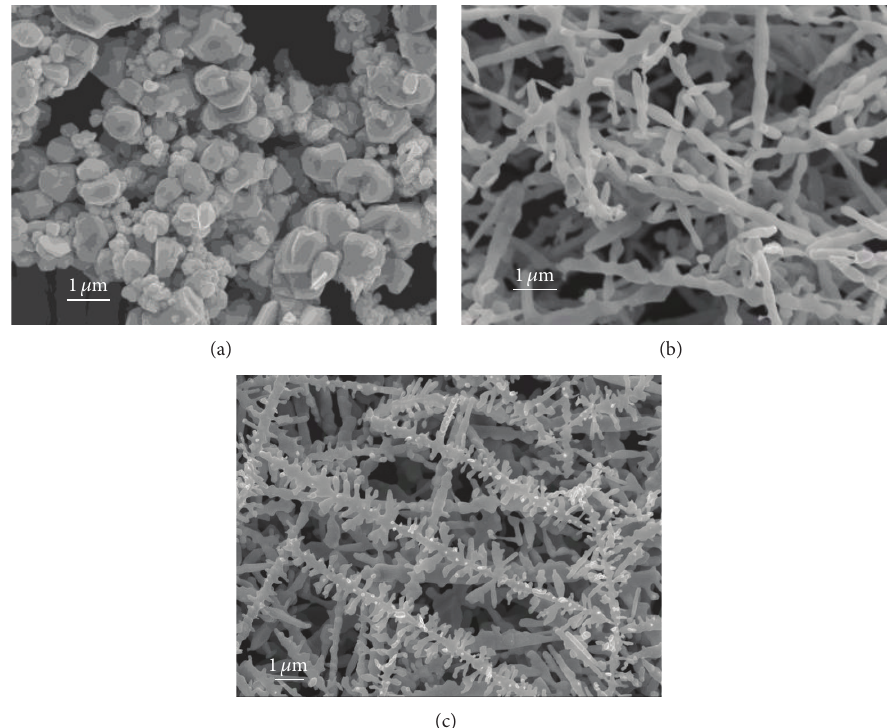
Figure 1: The SEM micrograph of Ag nanostructures deposited in 0.5 mM Ag 2 SO 4 at different potentials: (a) 0V, (b) − 0.1V, and (c) − 0.25